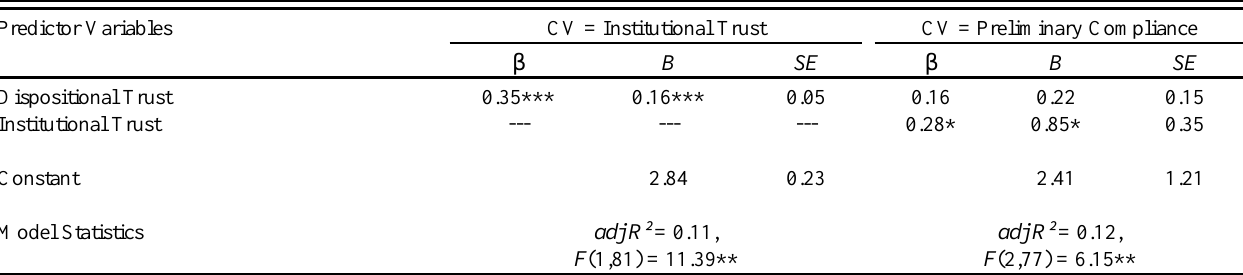
Table 2 . Preliminary compliance mediation